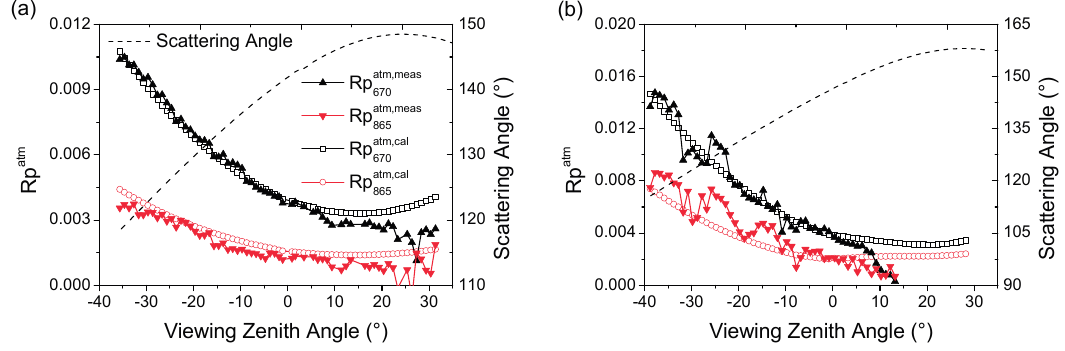
Figure 5. AMPR polarized reflectance measurements corrected for surface contribution based on measurements at 1640 nm and comparison with radiative transfer model RT3 calculations using Sun-sky radiometer AOD and polluted marine aerosol model as inputs. ( a , b ) These correspond to the two scans in Figure